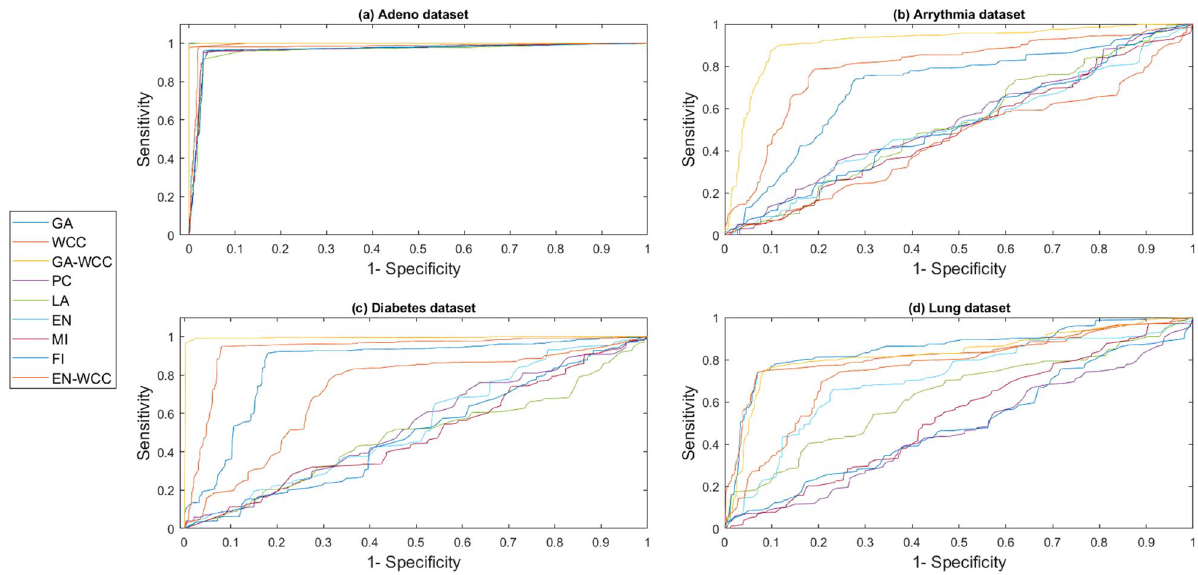
Figure 10. ROC curves of the methods on the first category of datasets. ( a ) The ROC curve of the manners on the Cancer dataset (Adeno dataset). Although all the methods have acceptable performance, the proposed method (GA_WCC) has higher separating power relative to the others. ( b ) The ROC curve of the methods on the Arrhythmia dataset. Like the first section, GA_WCC show better performance in term of classifying power. ( c ) The ROC curve of the manners on the Diabetes dataset. These results also validate that two-step and wrapper methods obtain better results than filter FS methods. ( d ) The ROC curve of the manners on the Lung